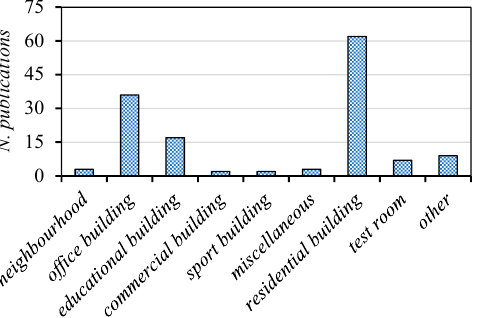
Figure 4. Case study typologies assessed in the reviewed journal articles. The “other” category in- cludes other building typologies such as public buildings and tourist centers.